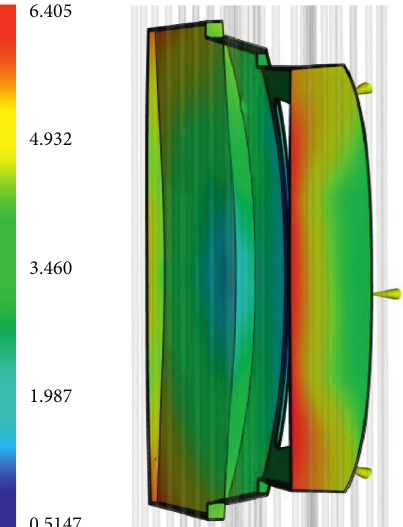
Figure 18: Warpage after